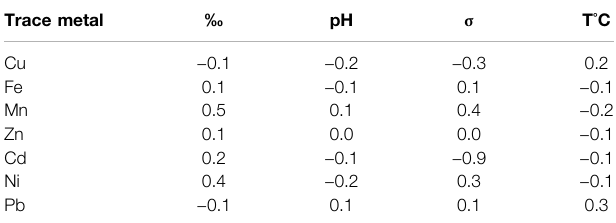
TABLE 2 | Pearson ’ s correlation results of the trace metal concentration in the edibletissueof C.bellicosus andtheseawaterphysicochemicalparametersof salinity ( ‰ ), pH, conductivity ( σ ), and temperature (T ° C).